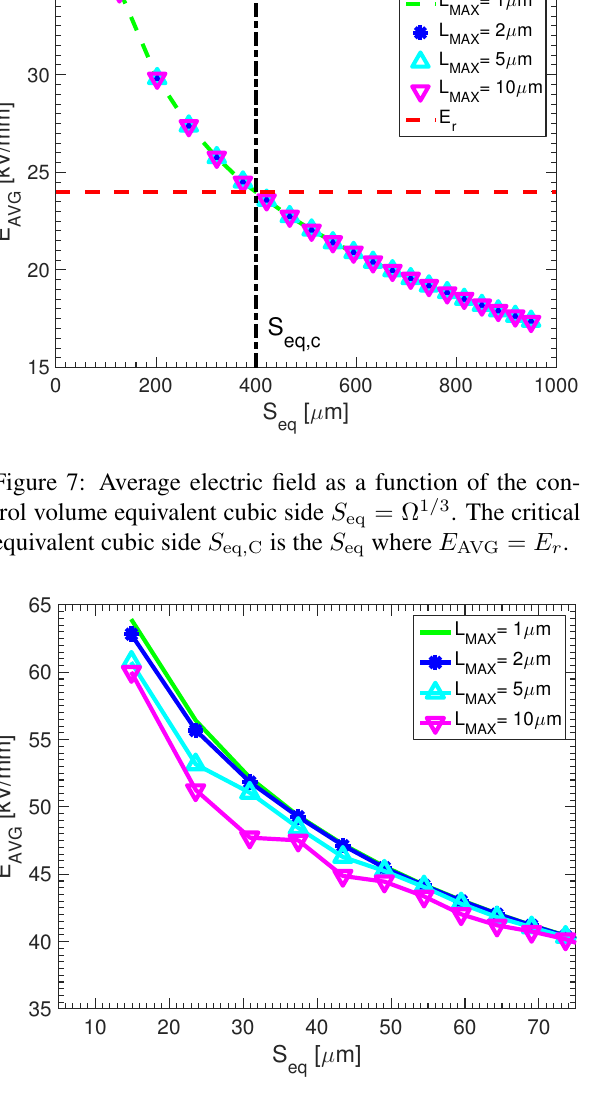
Figure 8: E AVG as a function of S eq varying L MAX , for small S eq . In this example. for S eq < 50 µ m, correspond- ing to about 5 times the reference L MAX , the E AVG metric suffers from mesh-dependence.